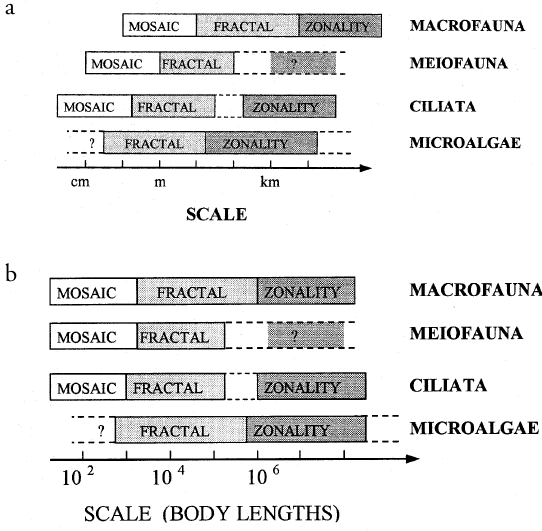
Fig. 2. Spatial ranges of different distribution patterns for various groups of intertidal benthos (axis is